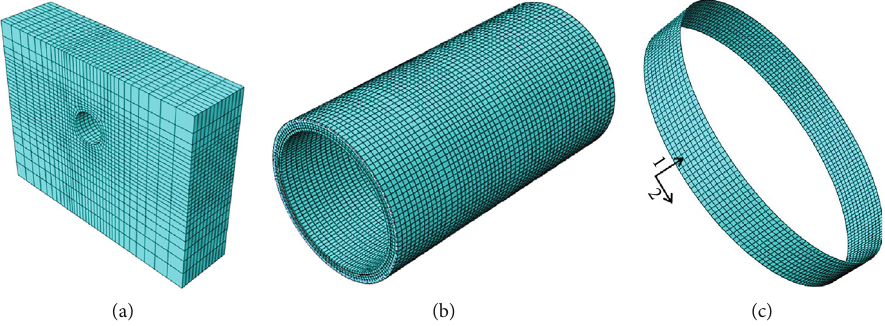
Figure 3: Three-dimensional mesh: (a) soil; (b) PCCP; (c) CFRP. Table 2: Material